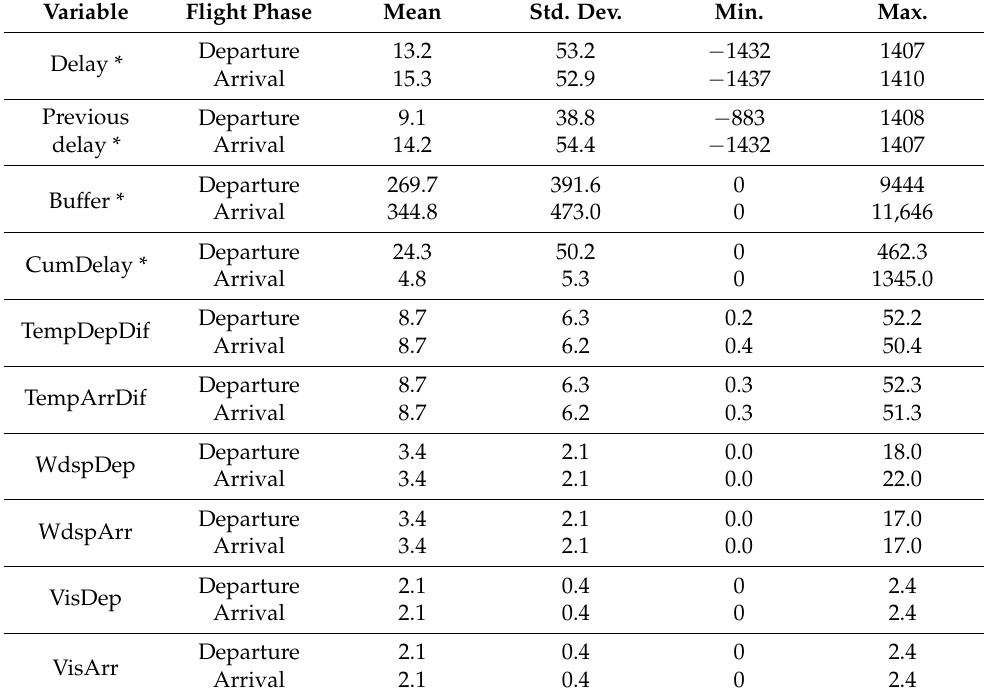
Table 2. Summary statistics of the variables in the specified models after data